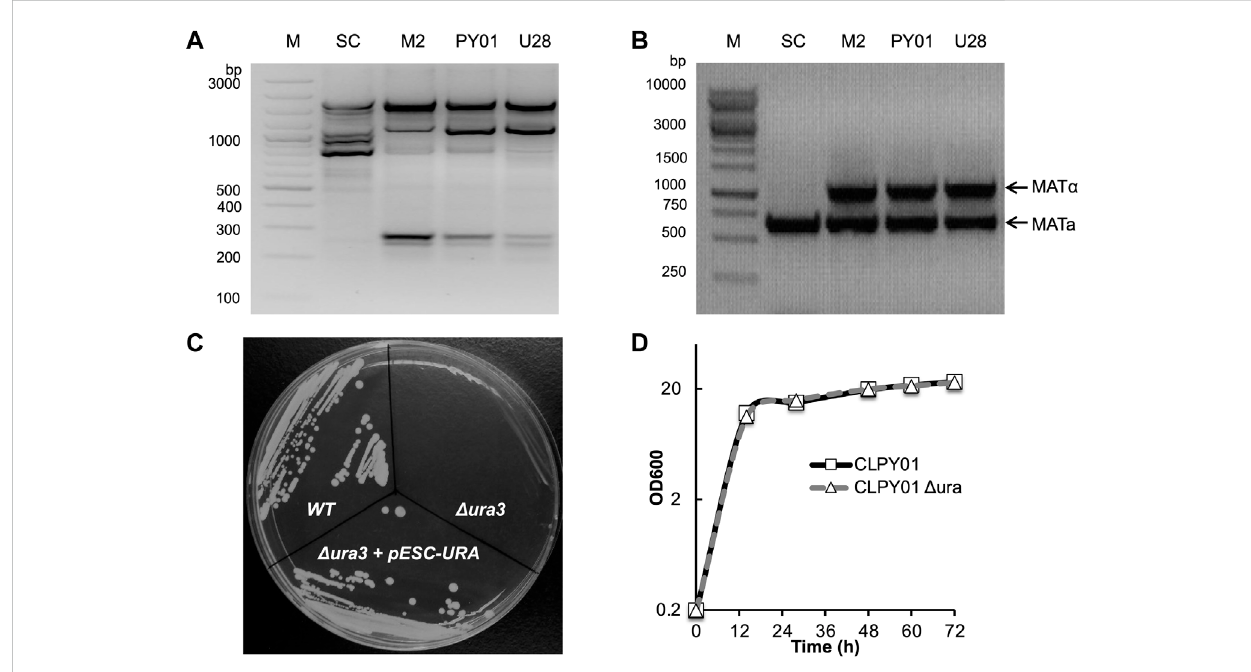
Identi fi cationofwildtypeand Δ ura3 boulardiistrains. (A) .PCRampli fi cationofbandsfromgenomicDNA. (B) .Ploidy. (C) .Phenotypeidenti fi cationof URA3 gene deletion. URA3 was deleted by using Cre-LoxP recombination. Cells were stroked onto an agar plate of minimal medium YGD without uracil. (D) . Growth pattern comparison of S. boulardii wild type and Δ ura3 strains in YPD medium at 30 ° C. WT, CLPY01 wild type, Δ ura3 , URA3 gene deletion mutant, Δ ura3 +pESC-Ura, Δ ura3 harboring